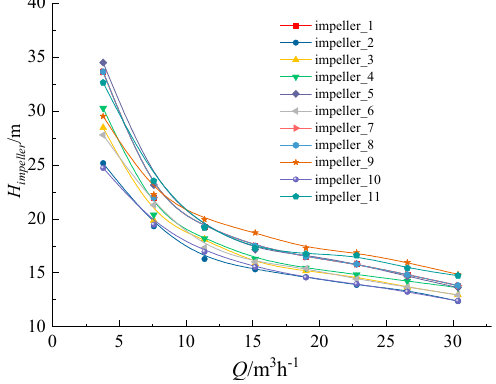
Figure 7. Head curves of impeller under different schemes.